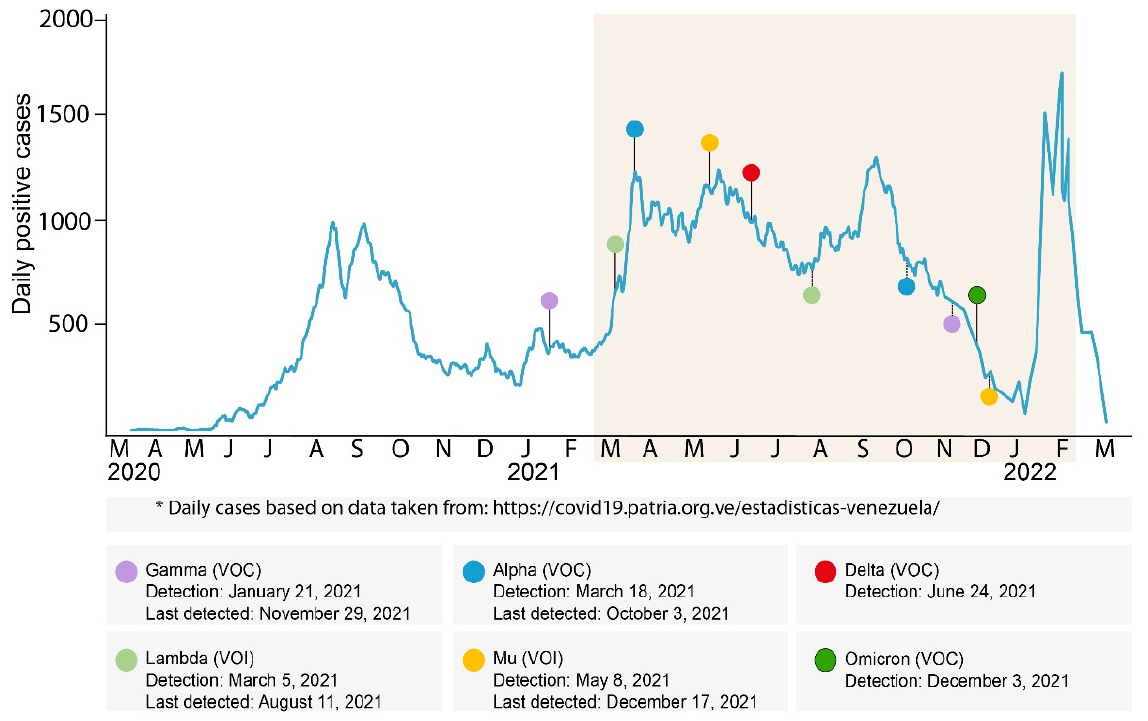
Figure 1. Timeline of cases and detection of VOIs and VOCs in Venezuela. The curve displays the number of COVID-19 cases reported for each day since the first case was detected in Venezuela. The colored shadow corresponds to the period studied. Upper circles represent the date of the first detection for each variant, and lower circles the date of the last detection. The date of the first and the last detection for each variant is based on a complete genome or a partial genome sequence. The date of the first detection of the Gamma VOC was reported previously [21].